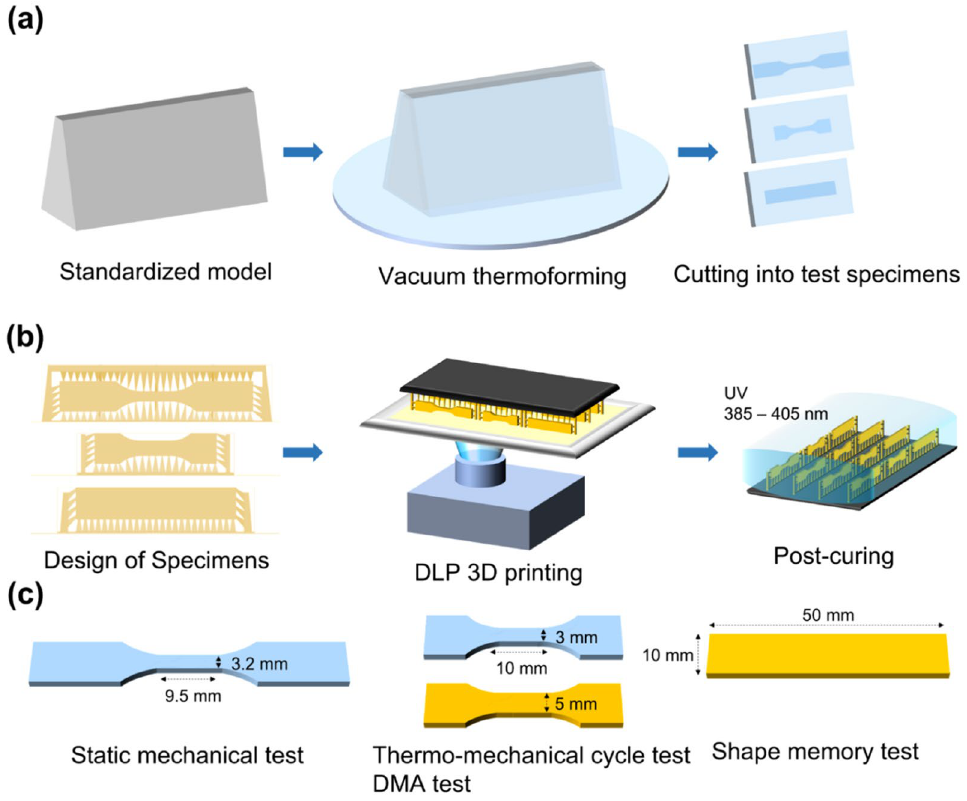
Figure 6. The preparing process and size of specimens; ( a ) Thermoplastic material (PETG); ( b ) 3D printed photocurable resin (TC-85); ( c ) size of